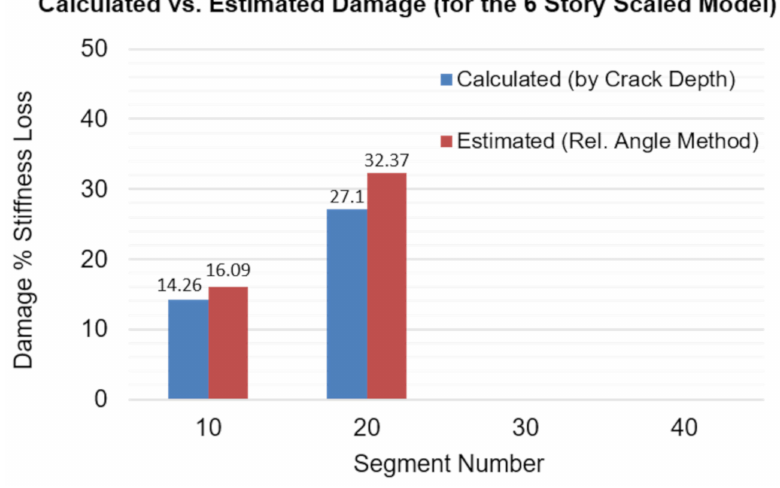
Figure 16. Location of the damaged column